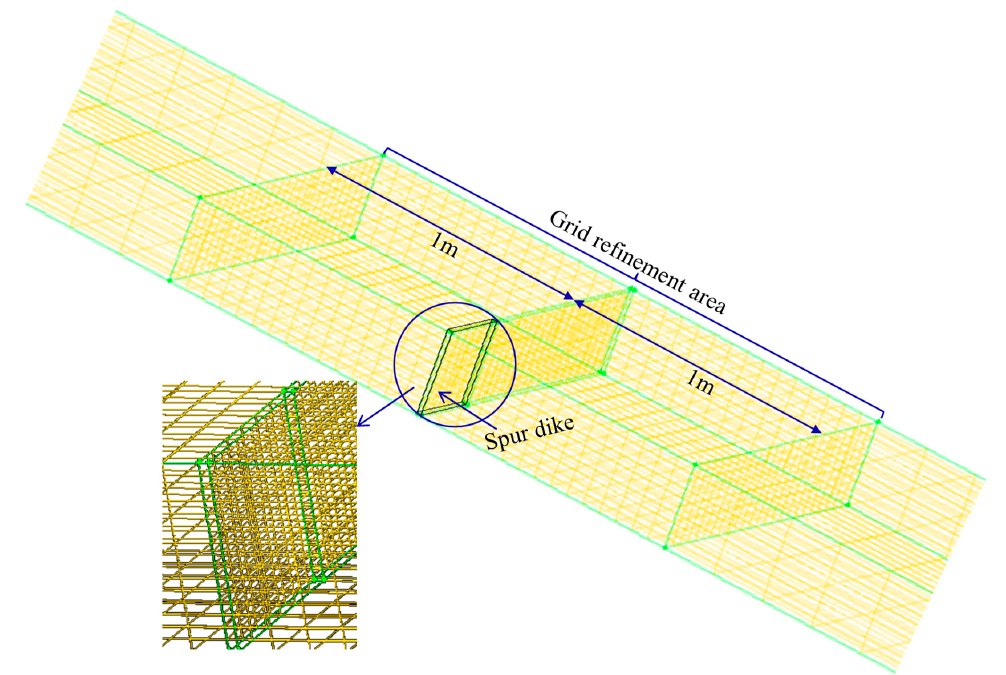
Figure 3. Local refined grids near spur dike.